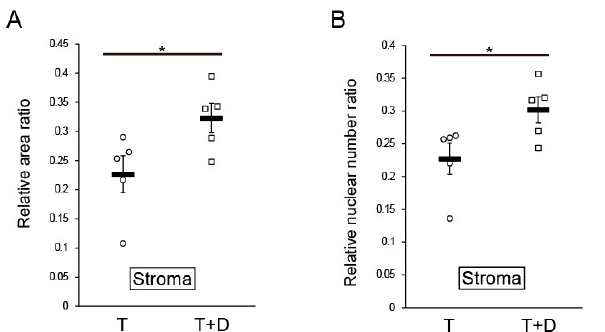
Figure 5. Quantitative analysis of regeneration potentials of silicone tube only (T) and tube-loaded DES (T+D). Based on the assumption that regeneration potential positively correlates with the area and cell (nuclei) number of the newly generated stroma, the total uterus/stroma ratio for these two parameters was calculated ( A , B ), as described in the text. The mean values of the relative area and nuclear number ratios obtained from the untreated normal tissue were 0.513 and 0.444, respectively. Values are expressed as mean ± SEM together and shown in dot plots of individual values obtained from the five independent experiments. * p < 0.05.